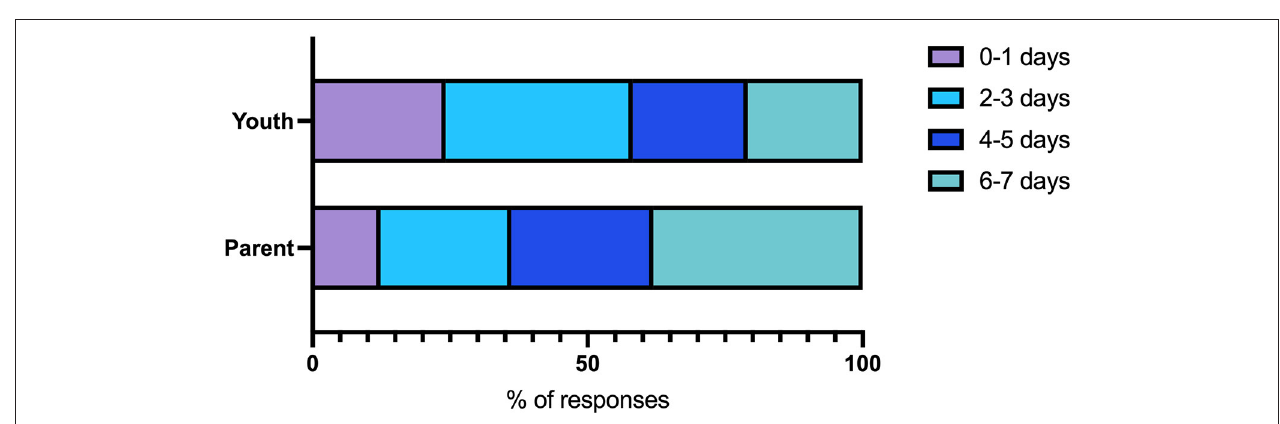
FIGURE 4 | Number of days children and youth played, did sports, or exercised for at least one h in the last week as reported by children and youth or parents.